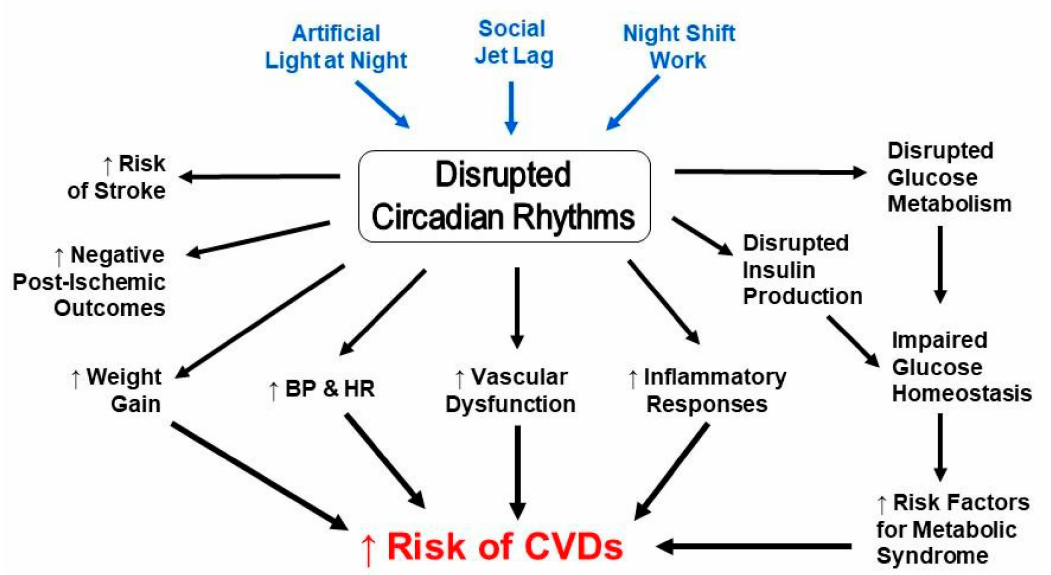
Figure 1. Circadian disruption and risk factors for cardiovascular diseases are